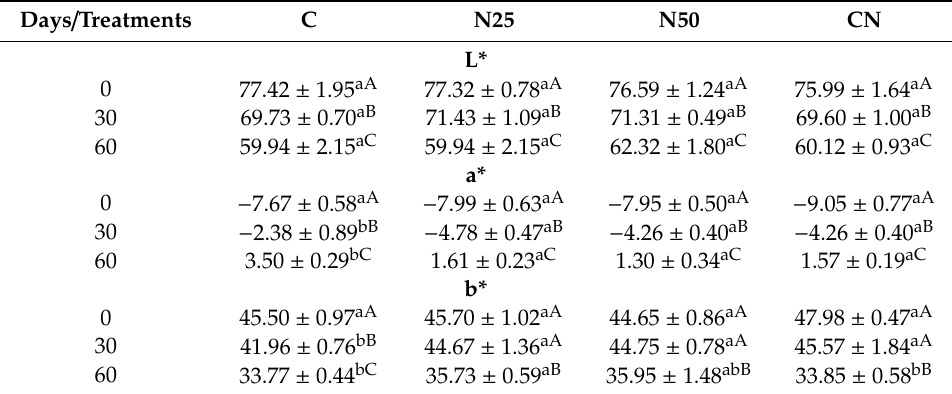
Table 3. Color changes in the mesocarp of the avocado during